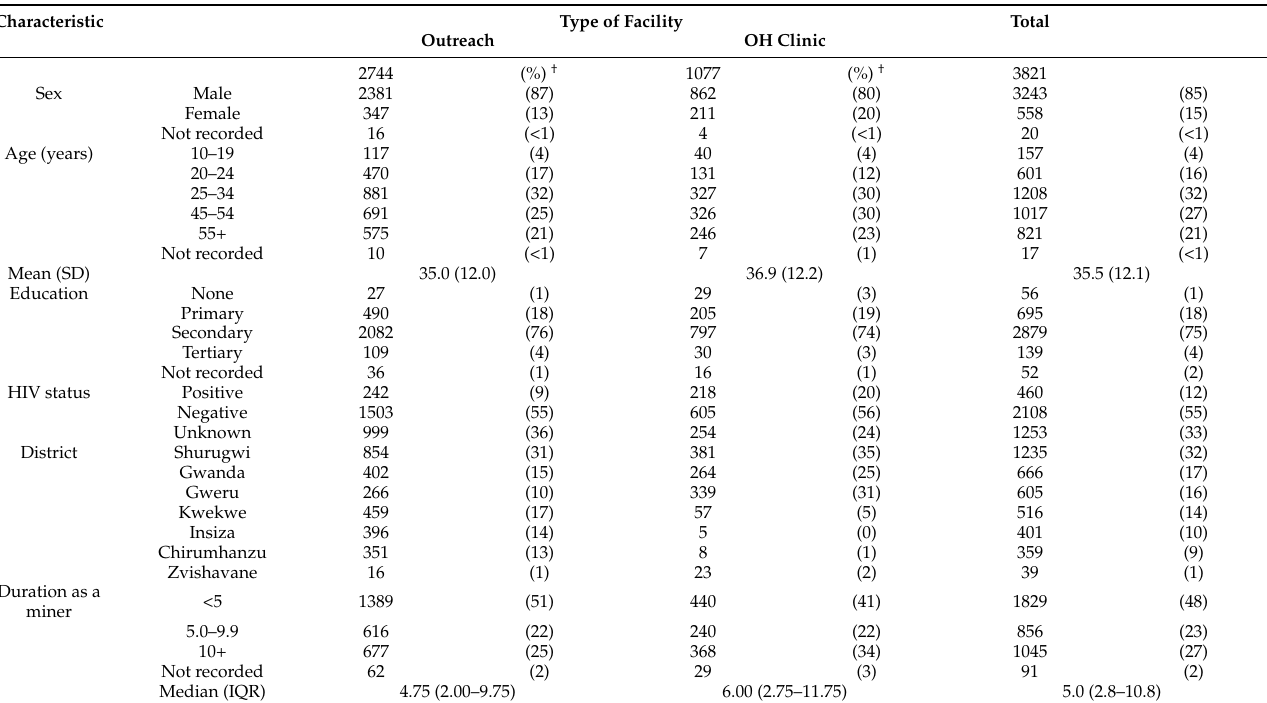
Table 1. Socio-demographic characteristics among artisanal and small-scale miners in Zimbabwe.